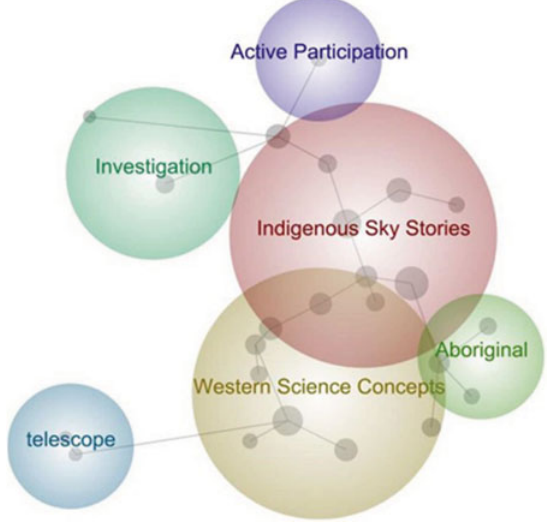
FIGURE 1 (Colour online) Lexical analysis of interviews conducted with Year 5 and Year 6